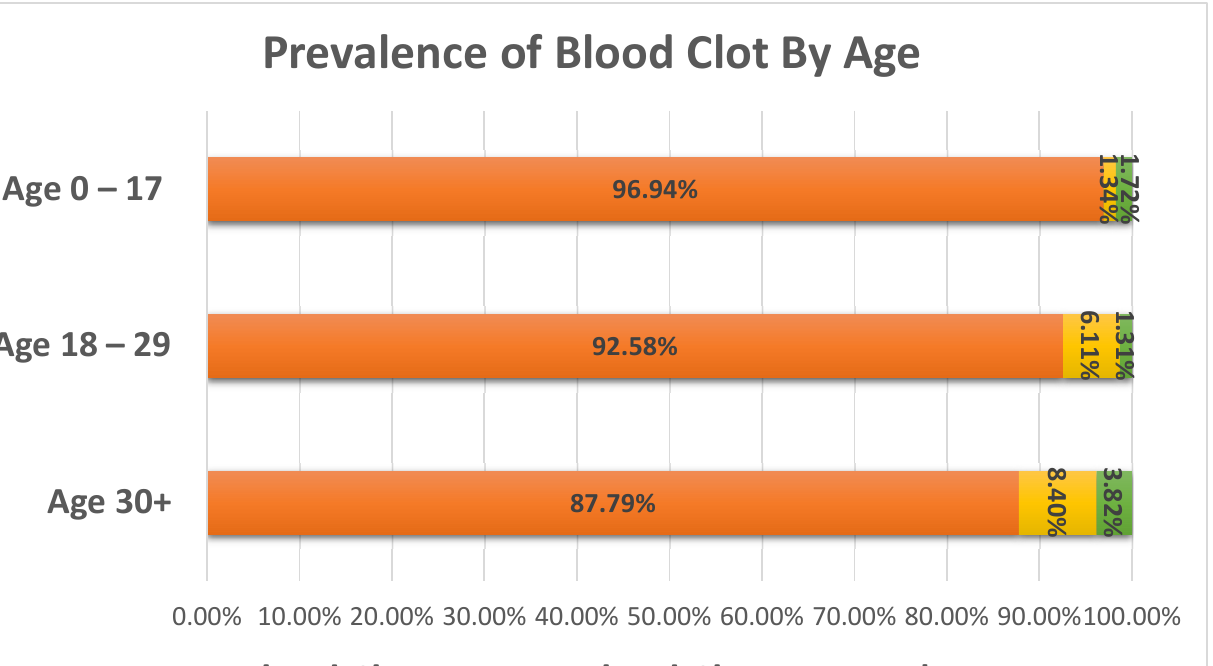
Figure 1. Prevalence of blood clots by age group in PWS participants who completed the Thrombosis History Survey. Respondents were asked whether the participant (i.e., the person with PWS) had ever had a blood clot. The age distribution of those participants over the age of 30 was 83